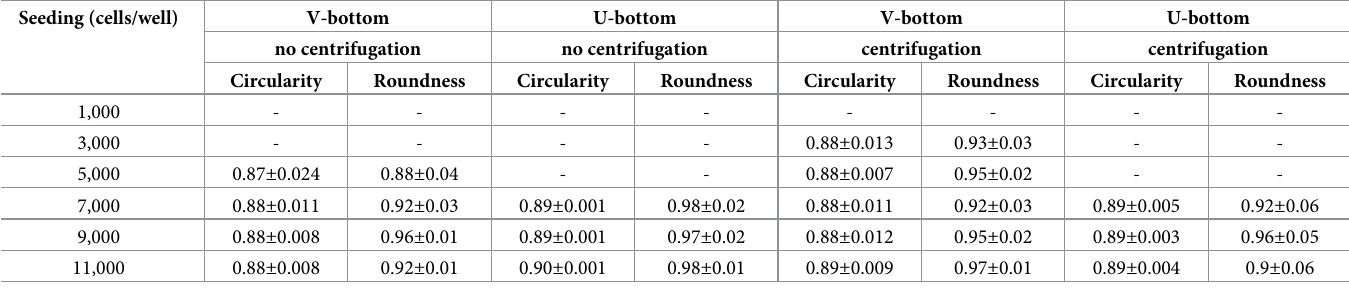
Table 1. Circularity and roundness, as determined by image analysis of embryoid bodies (EBs) cultured in V-bottom and U-bottom wells at different seeding densi- ties. All values were calculated after 6 days of induction. Seeding (cells/well) V-bottom U-bottom V-bottom U-bottom centrifugation centrifugation Circularity Roundness Circularity Roundness Circularity Roundness Circularity Roundness -